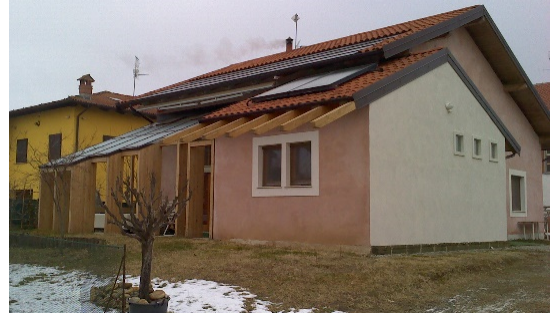
Figure 5. Casa Cembo in Saluggia (Vercelli), Italy.